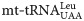
Effect of the mttu-1, mtcu-1 and mtcu-2 mutations on the modification status and steady-state levels of mt-tRNAs.(A and B) Analysis of the 2-thiolation status of mt-tRNAUAALeu (A) and mt-tRNAGln (B) by APM-Northern blotting. Total small RNAs obtained from mixed-stage populations of liquid-cultured worms were purified from wild-type (N2) and mttu-1, mtcu-1 or mtcu-2 strains, and analyzed in 10% polyacrylamide/8 M urea gels with (+) or without (-) 0.01 mg/ml APM. At least three replicates were performed. #Total small RNA stained with methylene blue. (C-F) Northern blot analysis of mt-tRNAUAALeu molecules after digestion with angiogenin in vitro. Three μg of total small RNA obtained from mixed-stage populations of liquid-cultured worms from N2 and mtcu-2 (C) or mtcu-1 (E) strains were digested with 12.5 μg/ml of angiogenin for the indicated times and mt-tRNAUAALeu and cyt-tRNALys were detected with a specific probe. Quantification of at least two independent assays similar to those shown in C and E is given in D and F, respectively. (G) Quantification of the steady-state levels of mt-tRNAUAALeu, mt-tRNAGln and 5S rRNA in mttu-1, mtcu-1 and mtcu-2 single mutants in comparison to the steady-state levels in wild-type strain (n≥3). (H) Quantification of mtDNA/nDNA ratio by qPCR. Four L4 worms grown at 20°C were used to quantify the mtDNA/nDNA ratio in each strain (n = 3). Error bars indicate ± SD (standard deviation). Statistical significance was evaluated with Student’s unpaired t-test. ** and *** denote p<0.01 and p<0.001, respectively.